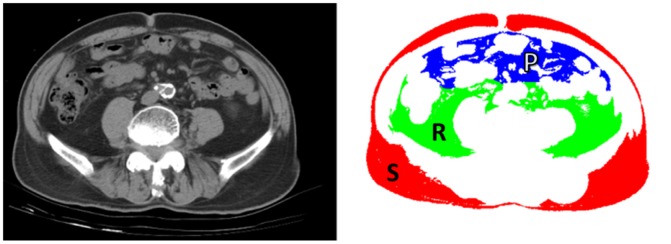
Image demonstration of determining abdominal fat distribution on a CT scan.Left, sample CT image obtained at the umbilicus level. Right, fat masks created for determining areas of subcutaneous fat (red, “S”), peritoneal fat (blue, “P”) and retroperitoneal fat (green, “R”) using methods described in the Materials and Methods section.